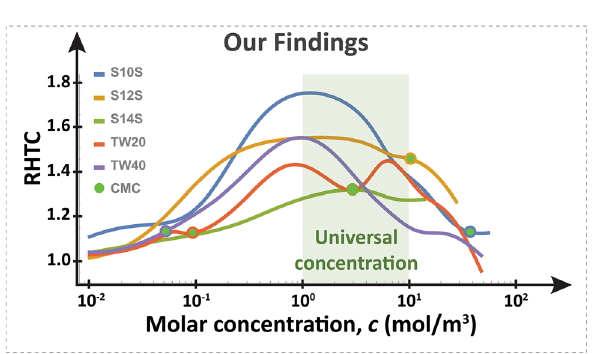
Figure 4. Our findings show that there is a universal, optimal concentration range of enhancement for a wide variety of surfactants, irrespective of their CMC. RHTC values are averaged in the range of 20–40 W/cm 2